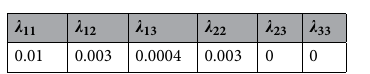
Table 4. Estimated decay rates after